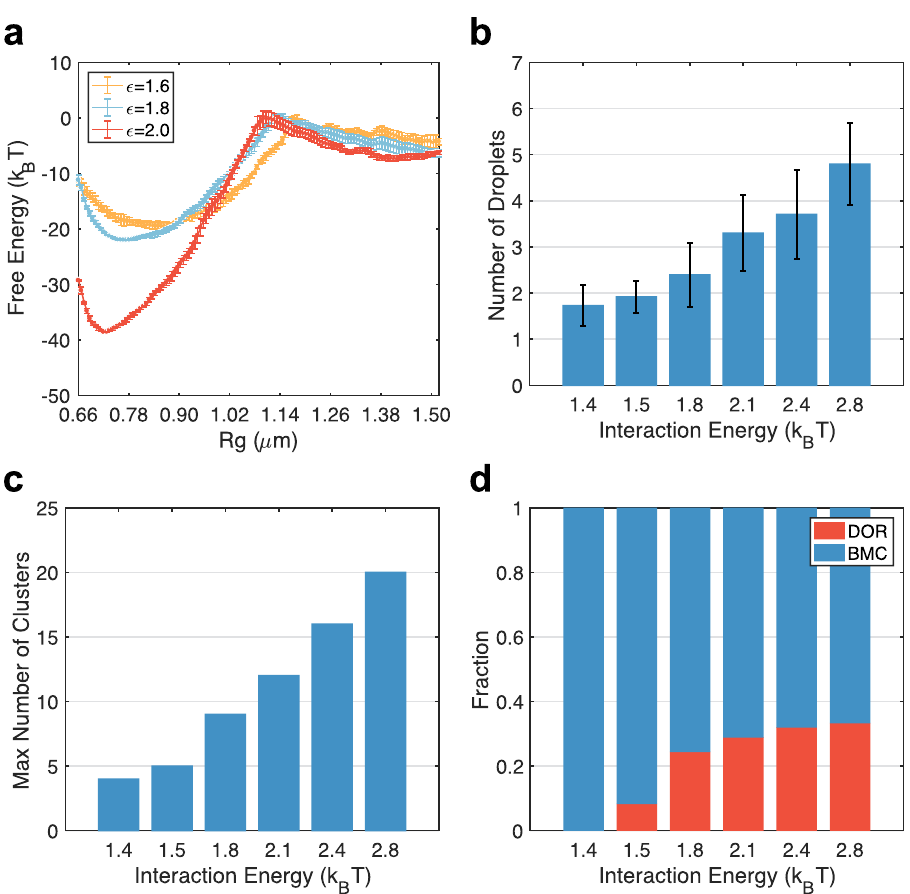
Fig. 6 Nucleoli-chromatin interactions promote cluster nucleation. a The free energy pro fi les of droplet coalescence at various nucleolar particle- chromatin interactions. The result for ϵ = 1.8 is identical to the one presented in Fig. 3. Error bars were calculated as standard deviation of the mean using block averaging by dividing the simulation trajectories into fi ve blocks of equal length. b Number of droplets formed at the end of 12 independent dynamical simulations at various strengths of nucleolar particle-chromatin interactions. Error bars correspond to standard deviations of results from independent trajectories. c The maximum number of clusters observed in dynamical trajectories performed at various nucleolar particle-chromatin interactions. d The fraction of cluster switching events following the Brownian motion-induced coalescence (BMC, blue) and the diffusion-limited Ostwald ripening (DOR, red) at various nucleolar particle-chromatin